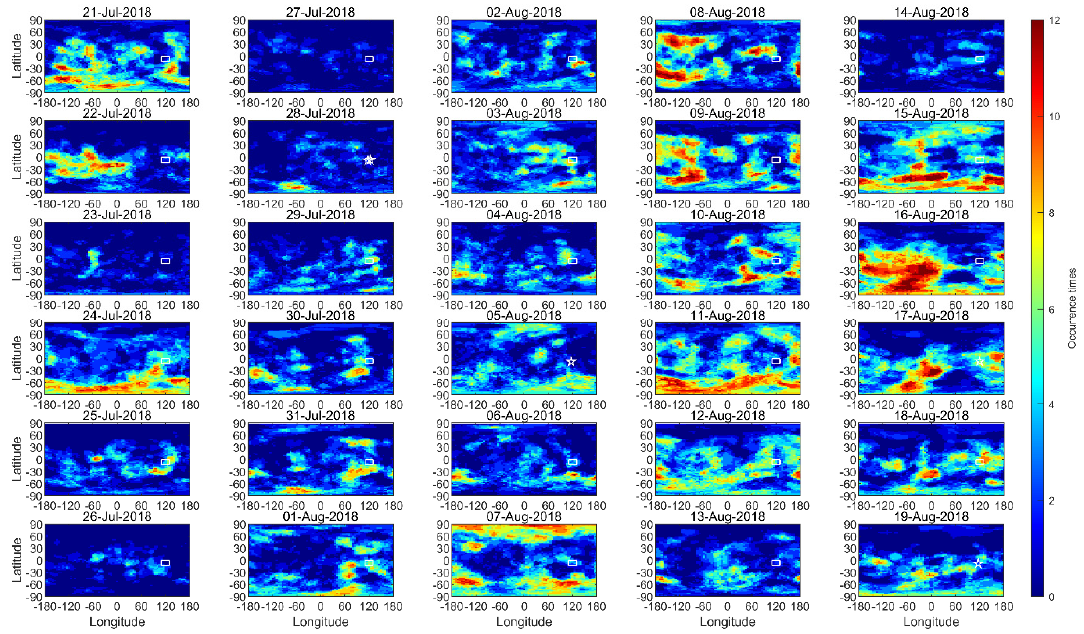
Figure 16. Same as Figure 15 for the daily occurrence times of the TEC increase anomaly.